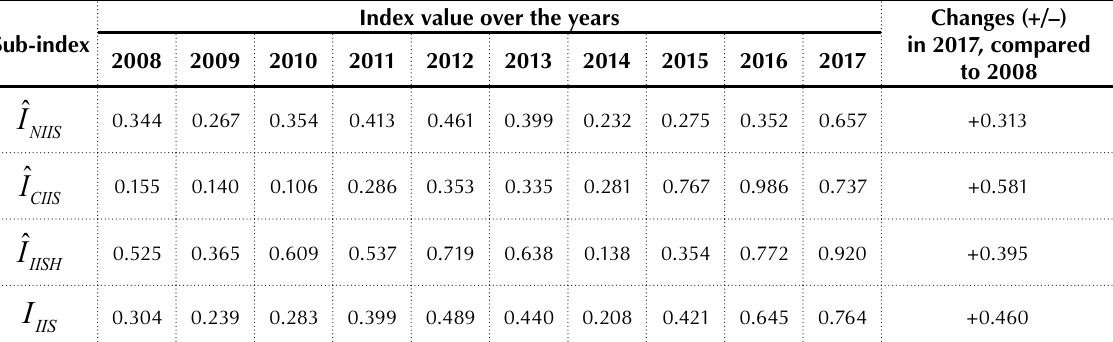
Table 9. Calculation of the integral index of the investment and innovation security of Ukraine